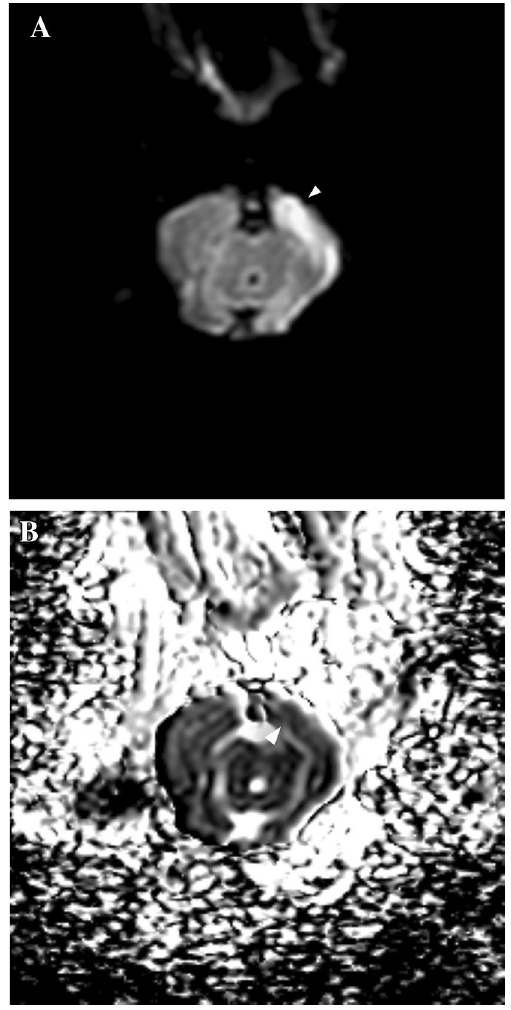
Figure 3. MR imaging of a rabbit showing an infarcted lesion. ( A ) Diffusion weighted imaging showing infarction (arrowhead) at the right temporal lobe. ( B ) Corresponding apparent diffusion coefficient